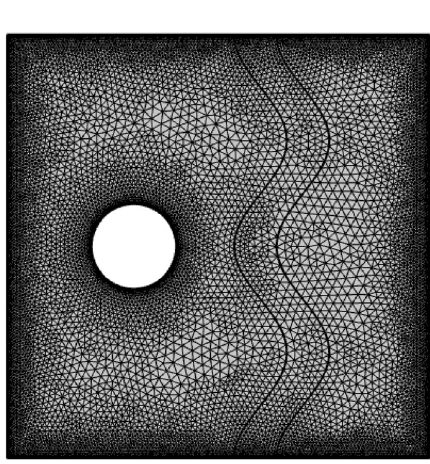
Figure 2. Sample mesh representation of the